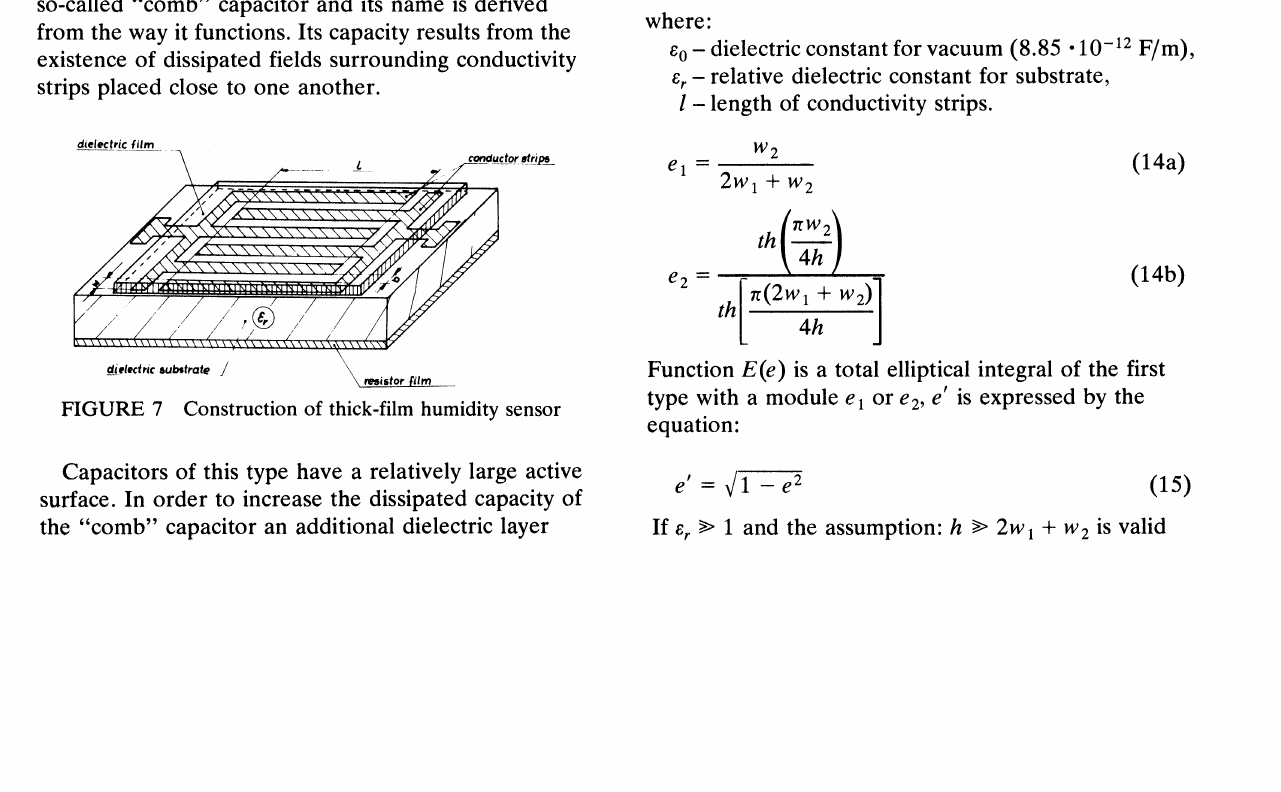
FIGURE 6 Examples of topologies for thick-film temperature sensors